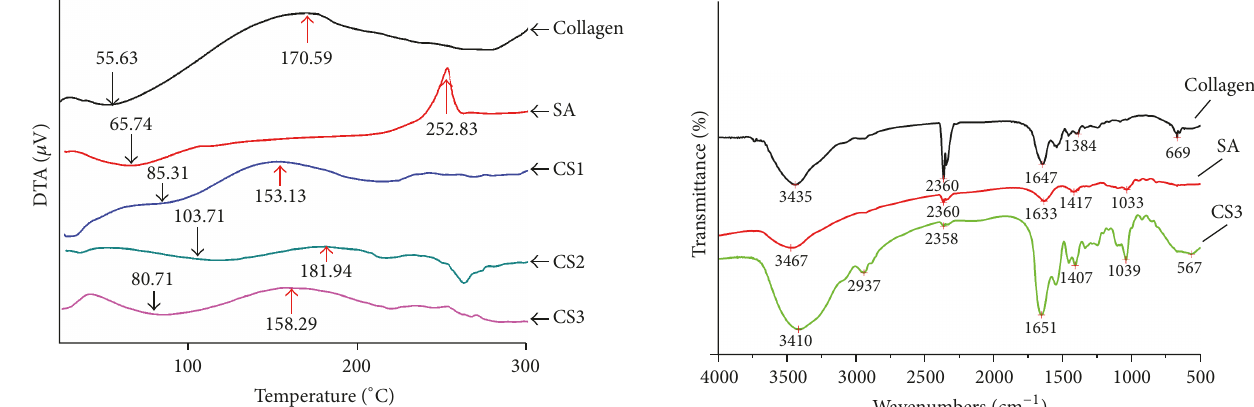
Figure 4: FTIR spectra of the different films (collagen, SA, and CS3) studied in all the range